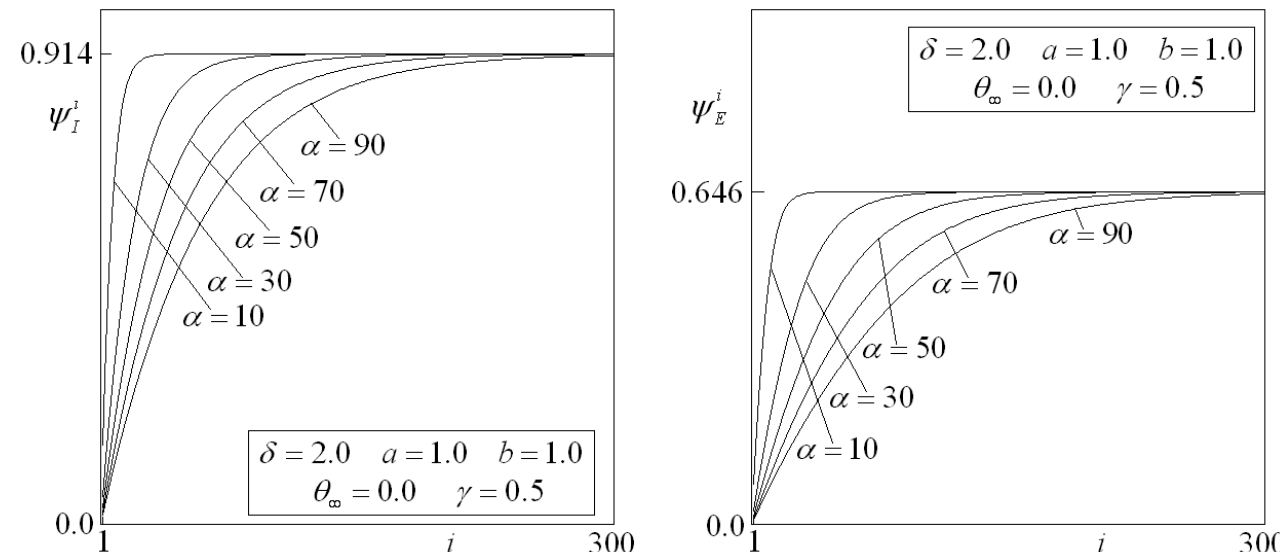
i  and i  represented as a function of i for five different values of Figure 5. The constants ψ i and ψ i represented as a function of i for five different values of the I E I E